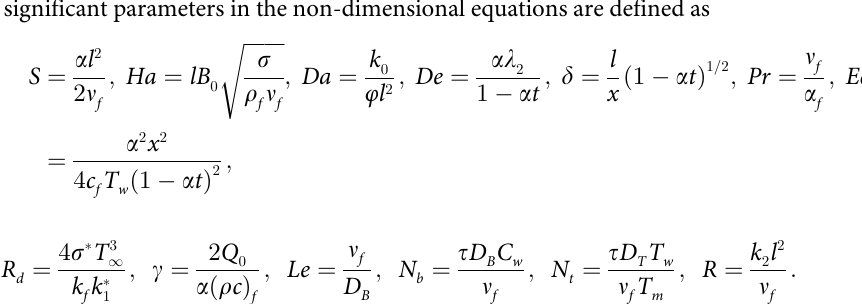
= 10 − 10 , Ha = γ = Ec = δ = R b